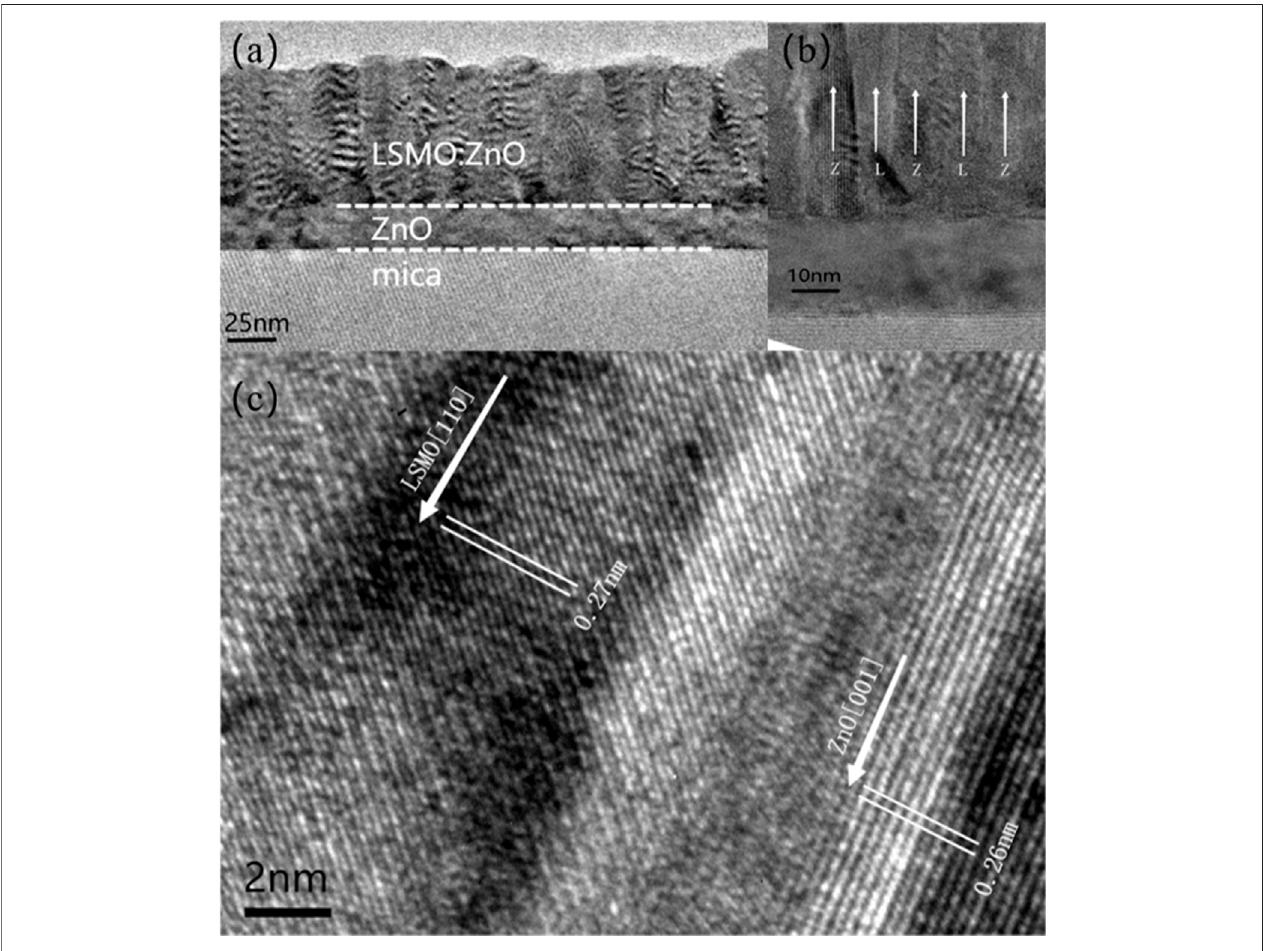
FIGURE 2 | Microstructure characterization on the LSMO:ZnO thin fi lm on buffered mica substrates. (A) Low-magni fi cation, (B) medium-magni fi cation, and (C) high-resolution TEM images of LSMO:ZnO on the ZnO buffered mica substrate.